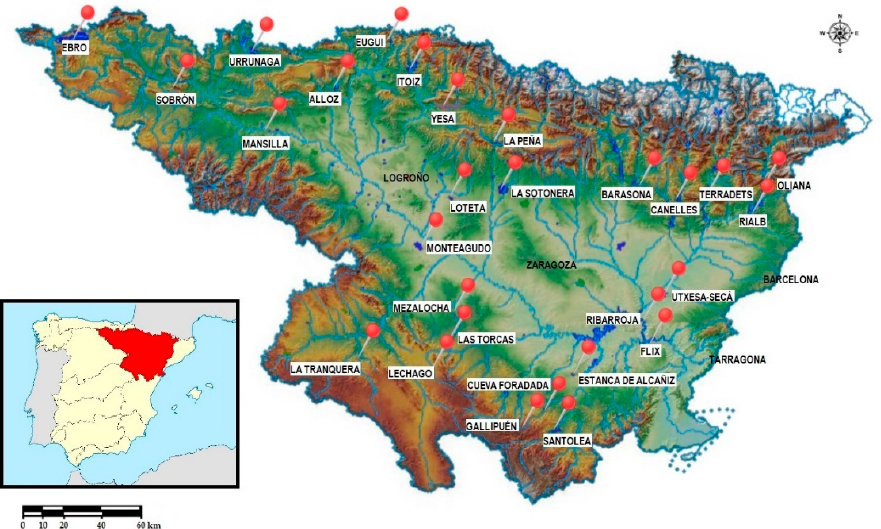
Figure 1. Location of selected reservoirs in the Ebro hydrographic watershed. Modified from [31].